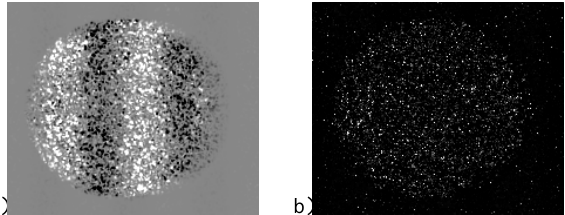
Figure 3: Estimated phase images; a) canopy phase, b) ground surface phase. Finally the height map is presented as in Figure 4.